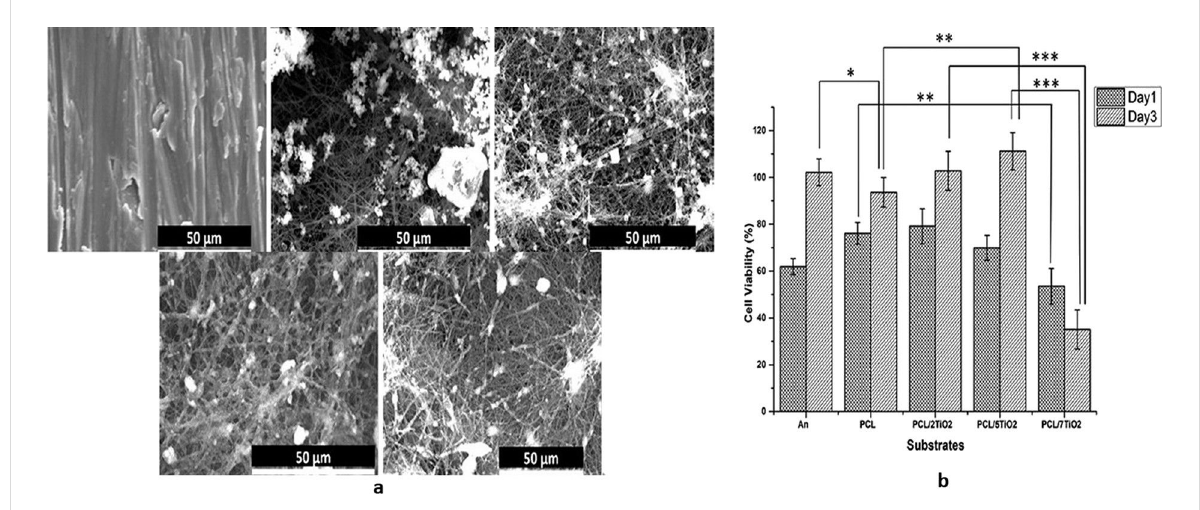
Figure 2: SEM images of (a) annealed Ti, (b) PCL, (c) PCL with 2 wt % TiO 2 , (d) PCL with 5 wt % TiO 2 , and (e) PCL with 7 wt % TiO 2 after immersing in simulated body fluid for 21 days. (f) Viability of hFOB cells on the five corresponding samples cultured on day 1 and day 3 ( p < 0.05) (Figure 2 was adapted from [60] (© 2018 A. S. K. Kiran et al., published by MDPI, distributed under the terms of the Creative Commons Attribution 4.0 International License, https://creativecommons.org/licenses/by/4.0).